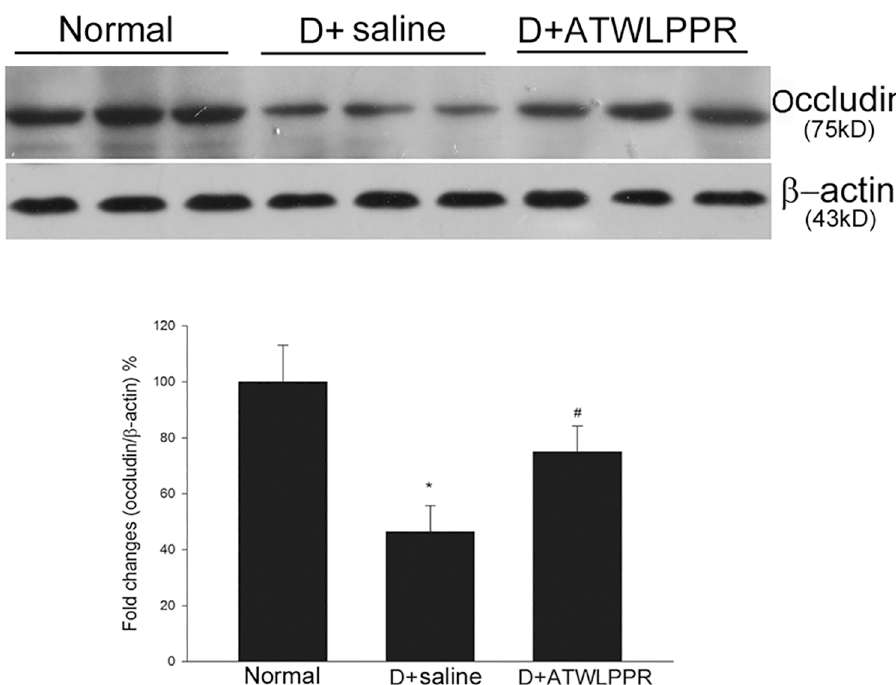
Fig 5. Diabetes-induced decrease in occludin was inhibited by treatment with ATWLPPR. * P < 0.05, versus the Normal group; # P < 0.05, versus the D+saline group. D,